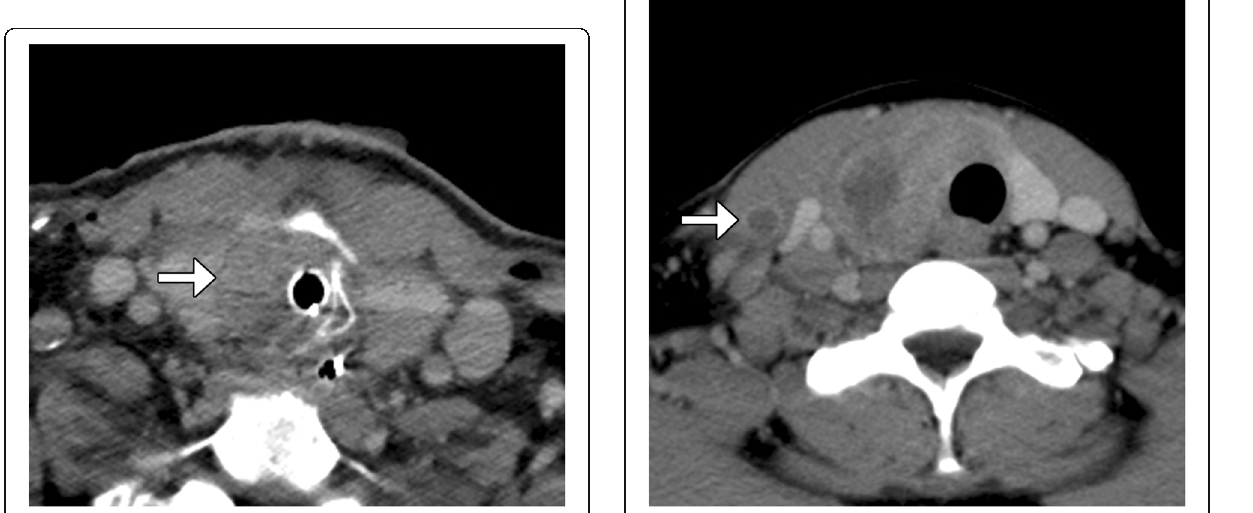
Fig. 3. Laryngeal neuroendocrine carcinoma. Axial CT image shows an infiltrative right laryngeal mass with extralaryngeal extension (arrow)